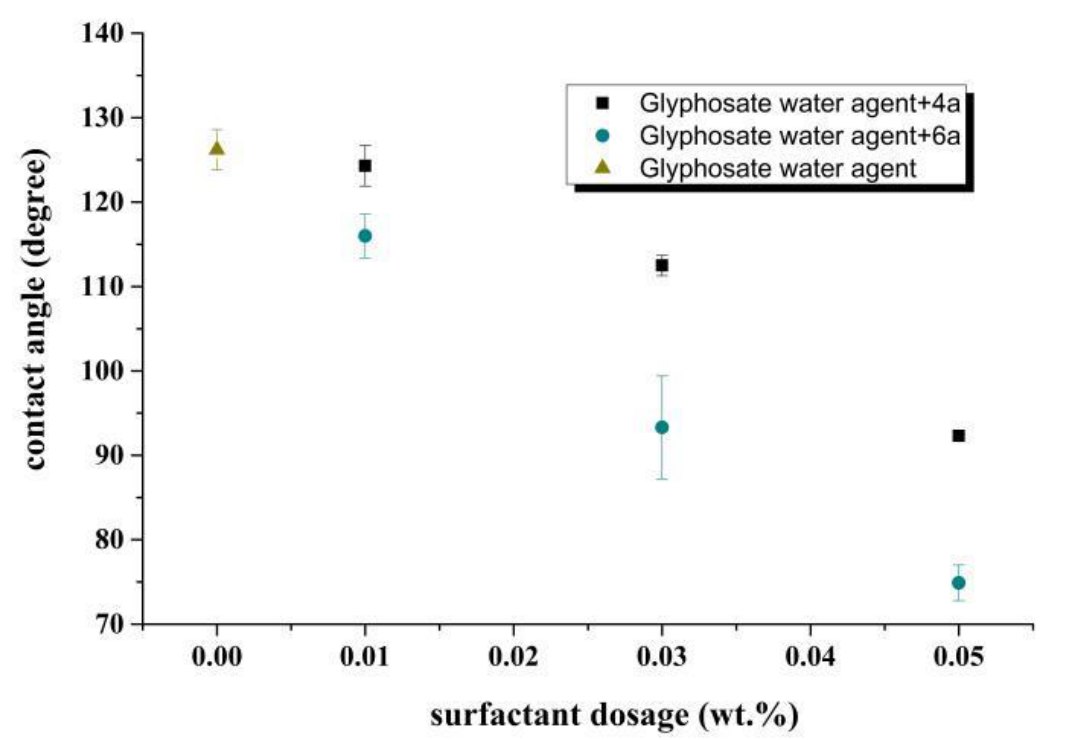
Figure 12. Contact angles of glyphosate water agent solutions containing surfactants 4a or 6a.